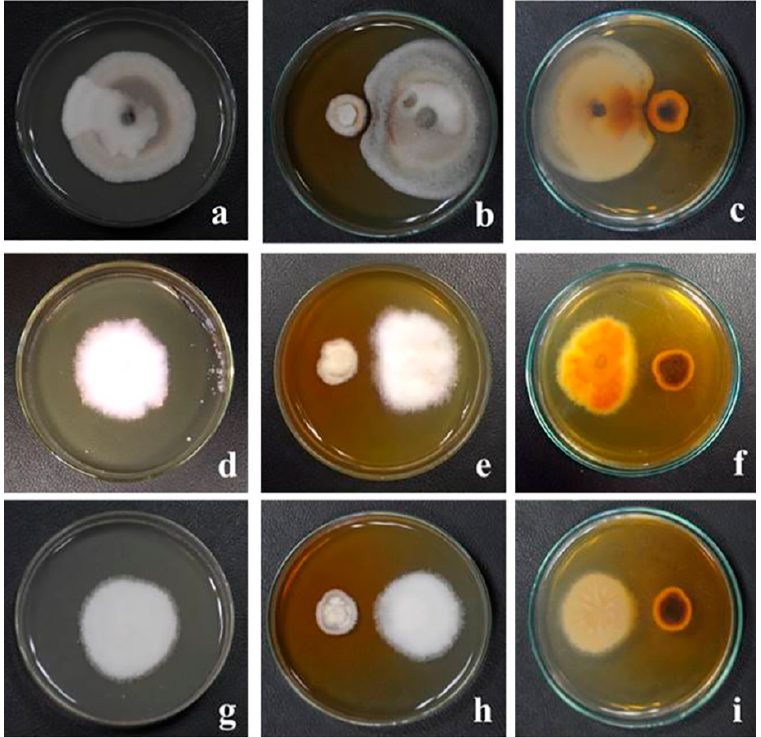
Figure 8. Antagonistic activity of G. triuniae NFCCI 4873: ( a ) C. gloeosporioides on PDA (control), ( b , c ) G. triuniae against C. gloeosporioides on PDA (front and reverse view), ( d ) F. oxysporum on PDA (control), ( e , f ) G . triuniae against F. oxysporum on PDA (front and reverse view), ( g ) F. solani on PDA (control), and ( h , i ) G. triuniae against F. oxysporum on PDA (front and reverse view).